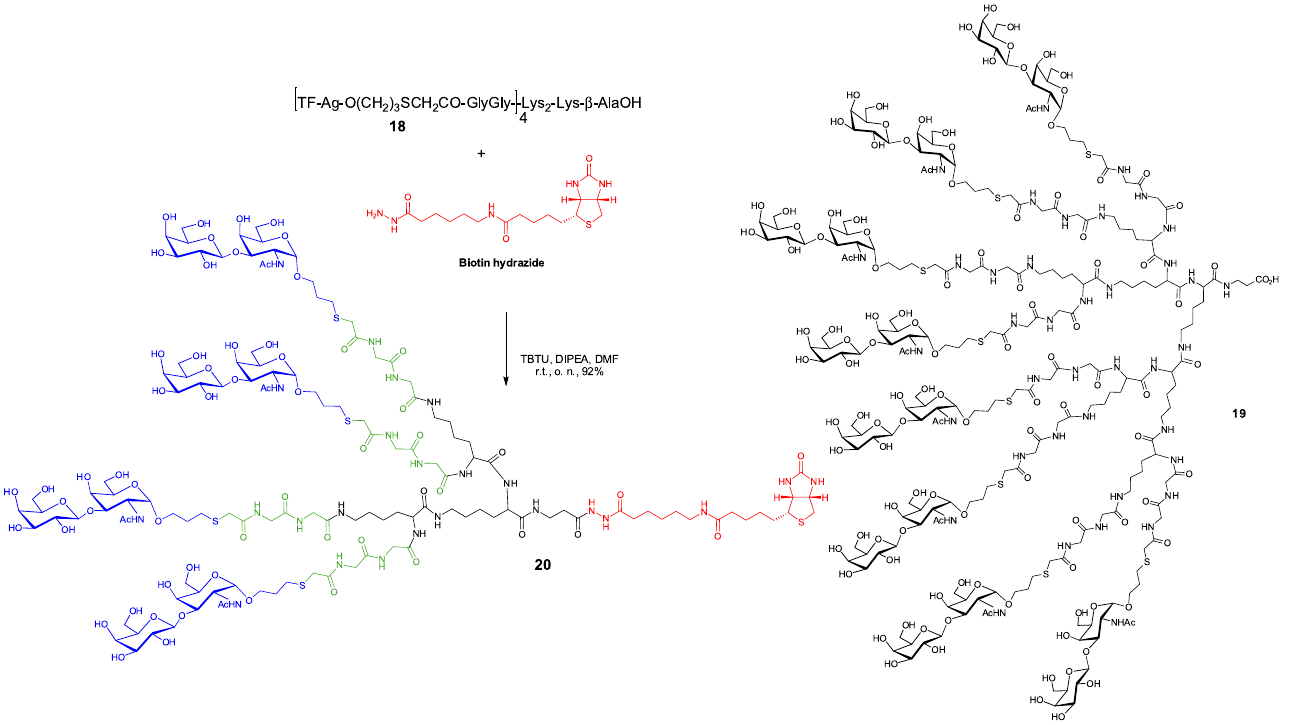
B monomer (both α - and ε -amino groups 2